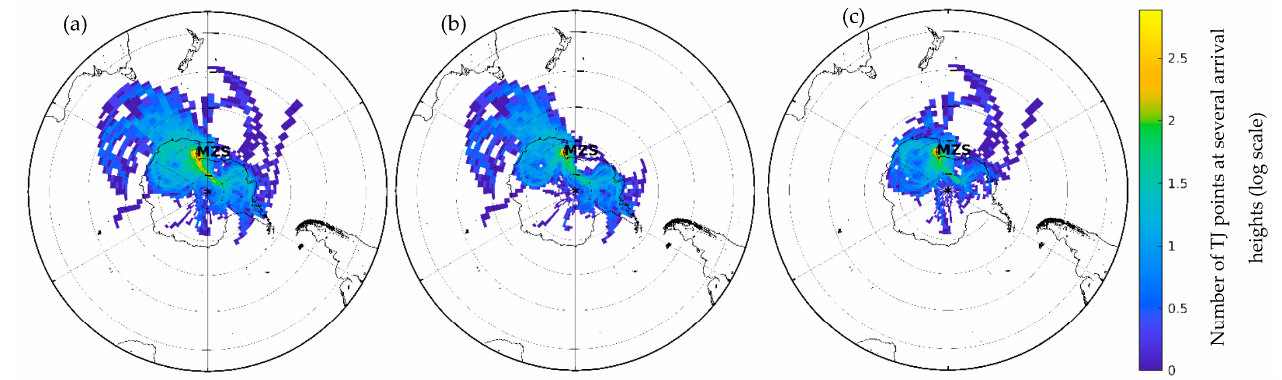
Figure 5. Total number of trajectories arriving at 500, 1000, 1500, and 2000 m above MZS, laying within each cell grid (4° × 1°). Panel ( a ) refers to the whole trajectory dataset, panel ( b ) to December, and panel ( c ) refers to January. Data are reported on a logarithmic scale.